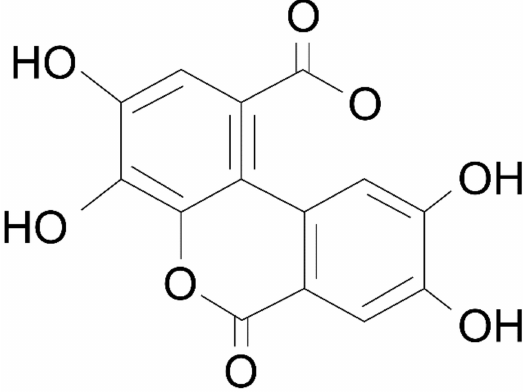
Figure 8. The chemical structure of ellagic